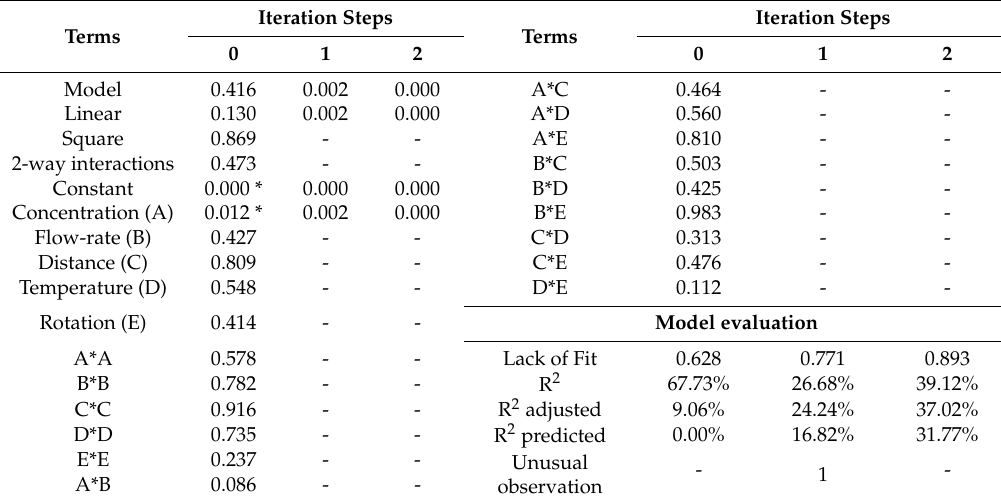
Table 3. Summary of response surface analysis for fibre diameter.